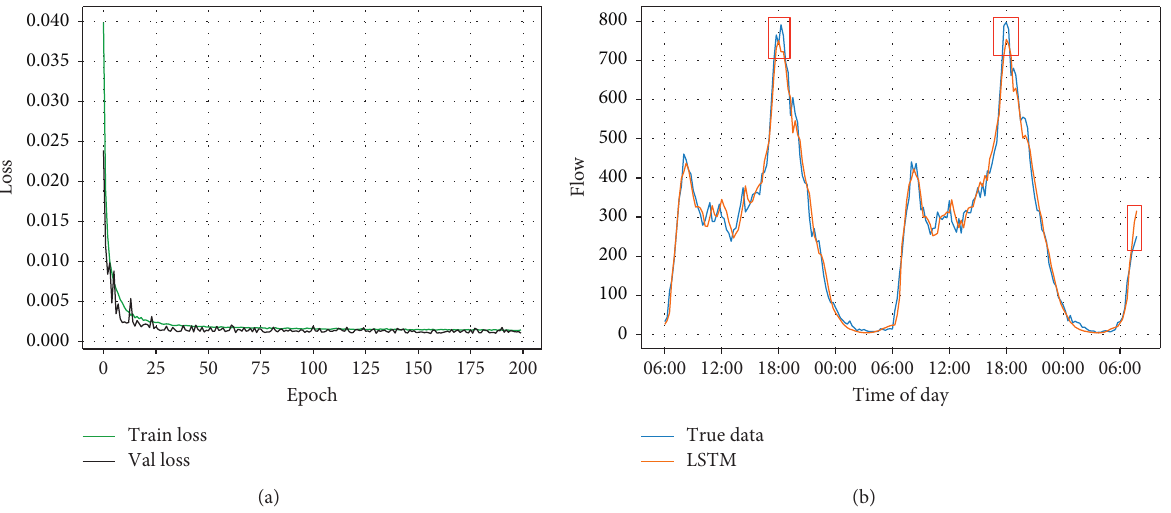
Figure 11: 16 steps LSTM training and prediction. (a)16 steps LSTM loss function and (b) 16 steps LSTM prediction results.